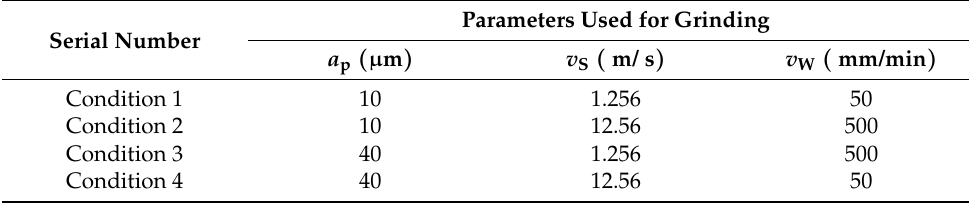
Table 4. Process parameters used to determine the empirical formula of side grinding force.